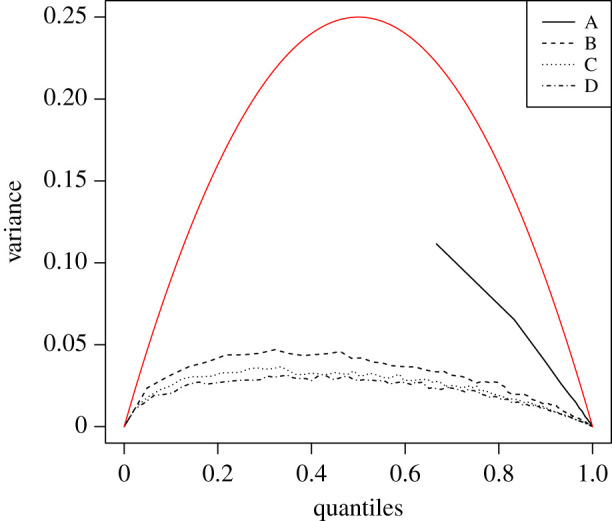
Brownian Bridge’s empirical variance with A:(w = 1, m = 1), B:(w = 134, m = 23), C:(w = 267, m = 44), D:(w = 400, m = 51). Top line (red in online version) is the variance under independent degree sampling (see appendix A). Line A is complete, but starts from the first rescaled degree Fsp(0;1, 1) = 0.66. (Online version in colour.)